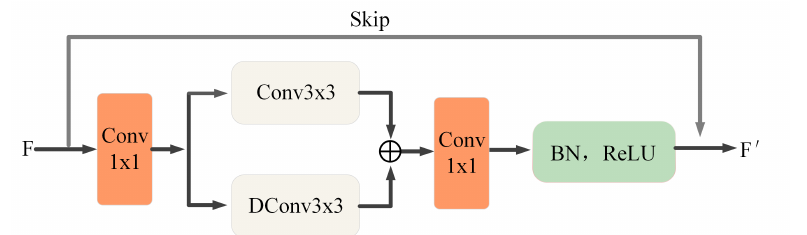
Figure 2. Figure of downsampling module.